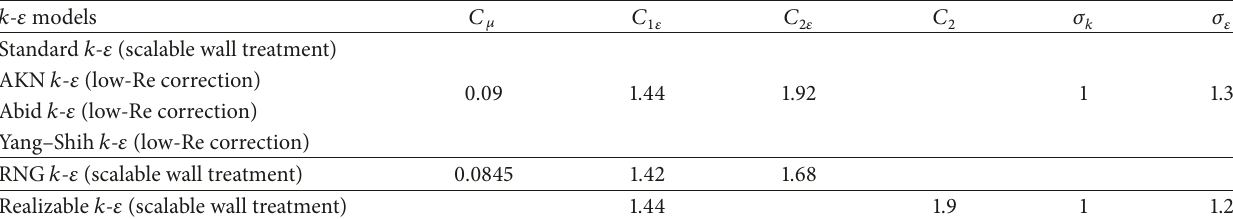
Table 5: Parameters of 𝑘 - 𝜀